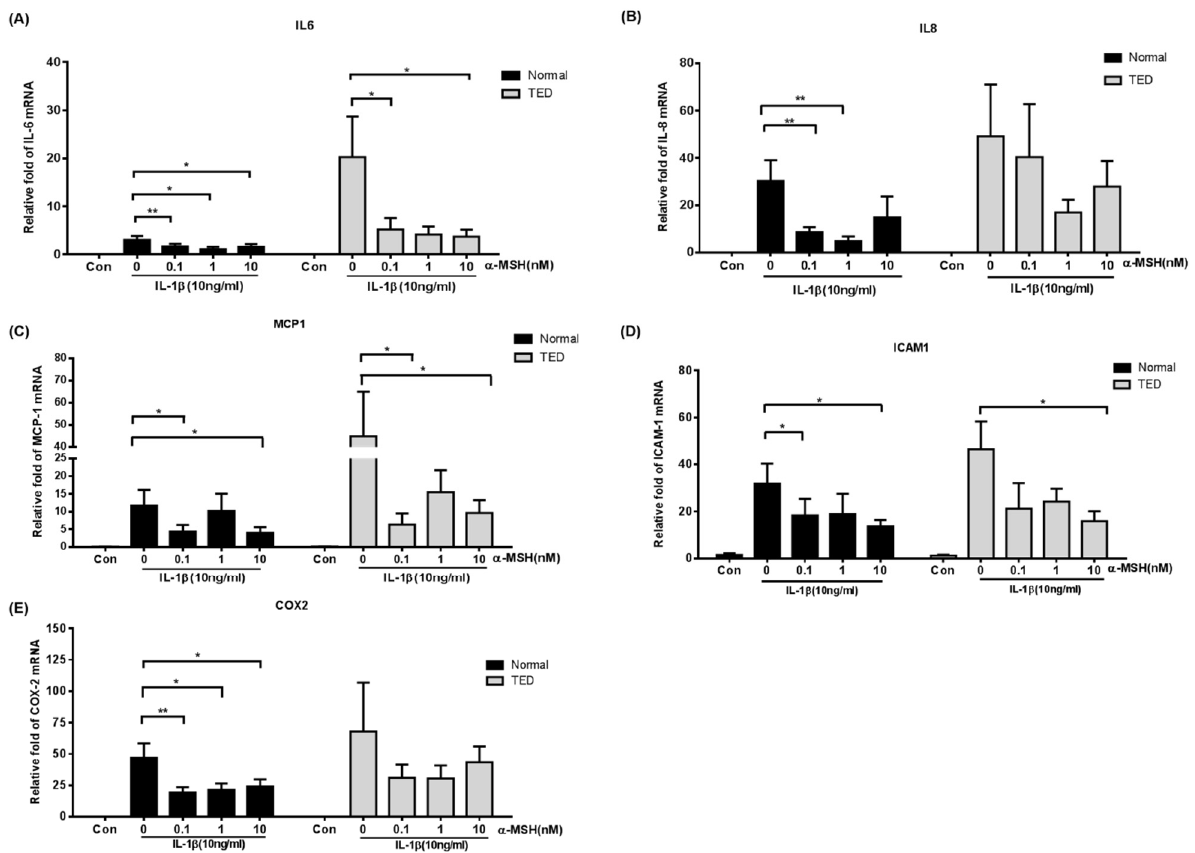
Figure 3. Effect of α -MSH on IL-1 β -induced IL-6, IL-8, MCP-1, ICAM-1 and COX-2mRNA expression in normal and TED orbital fibroblasts. Orbital fibroblasts obtained from normal or TED subjects were given 10 ng/mL IL-1 β for 16 h with α -MSH (0–10 nM) pretreatment for 6 h. IL-6 ( A ), IL-8 ( B ), MCP-1 ( C ), ICAM-1 ( D ) and COX-2 ( E ) mRNA levels were evaluated using qPCR. Gene transcriptional levels of the cytokines are shown as mean ± SEM fold change in cytokine mRNA levels relative to control without α -MSH treatment. Experiments were performed in triplicates using cells from six different donors. * p < 0.05, ** p < 0.01 as compared to cells without α